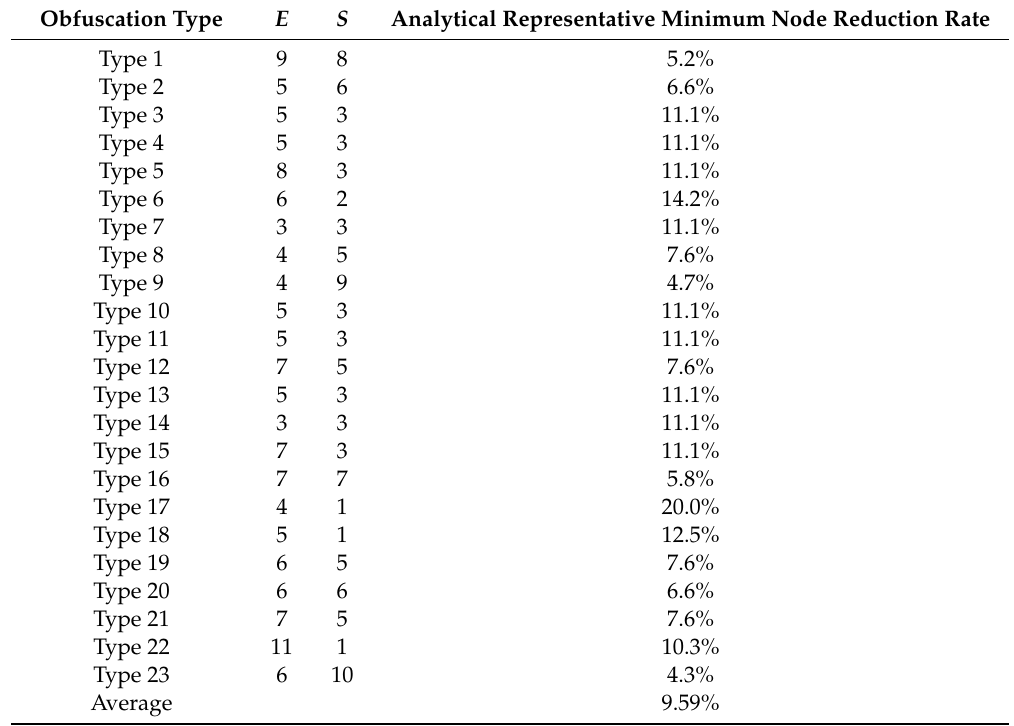
Table 2. Analytical representative minimum node reduction rate according to obfuscation